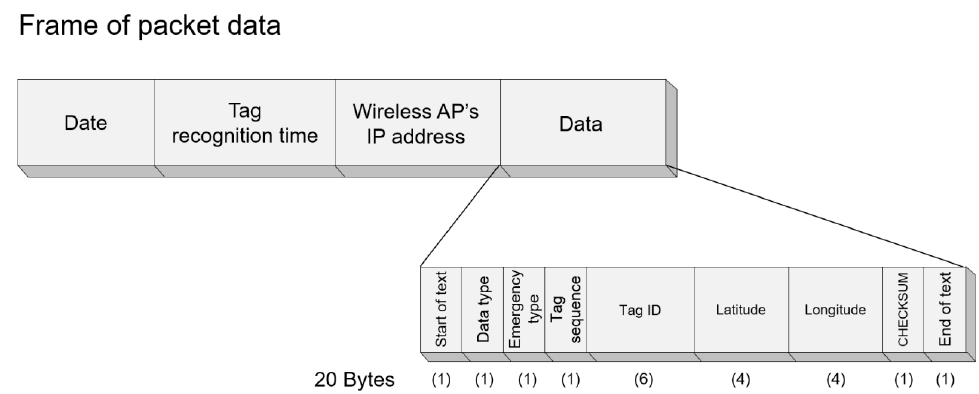
Figure 3. Packet-data frame derived using information communication technology (ICT)-based mine-safety-management system.